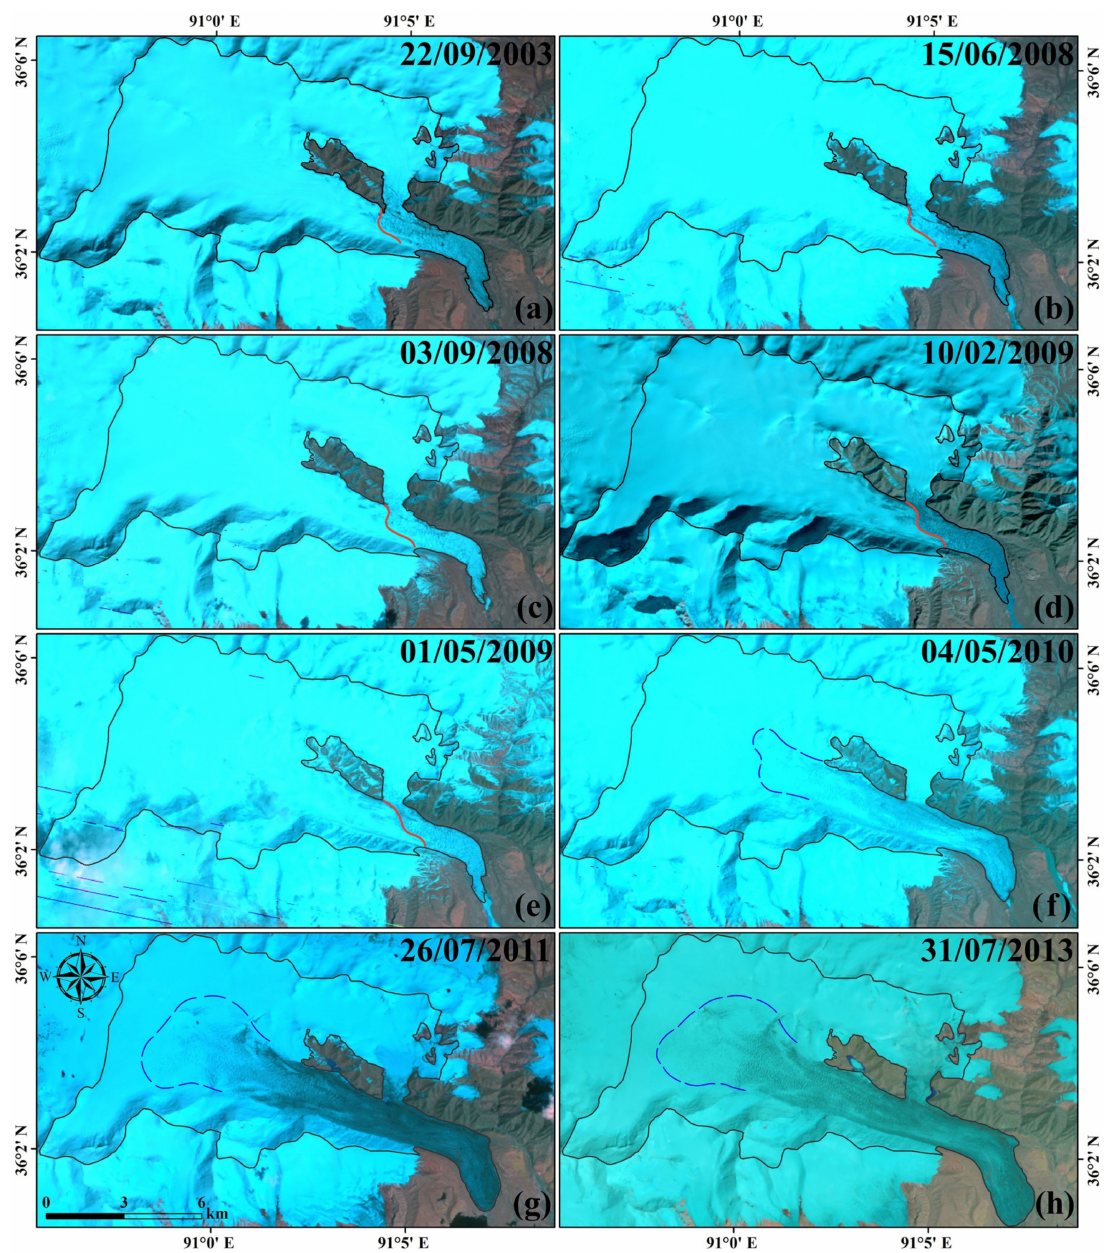
Figure 5. Morphological changes of the Monomah Glacier from 22 September 2003 to 31 July 2013. Backgrounds: false-color Landsat images; black lines: boundary of the Monomah Glacier; red line: demarcation line between smooth and mottled zones; blue dashed line: demarcation line between smooth and crevasse-developing